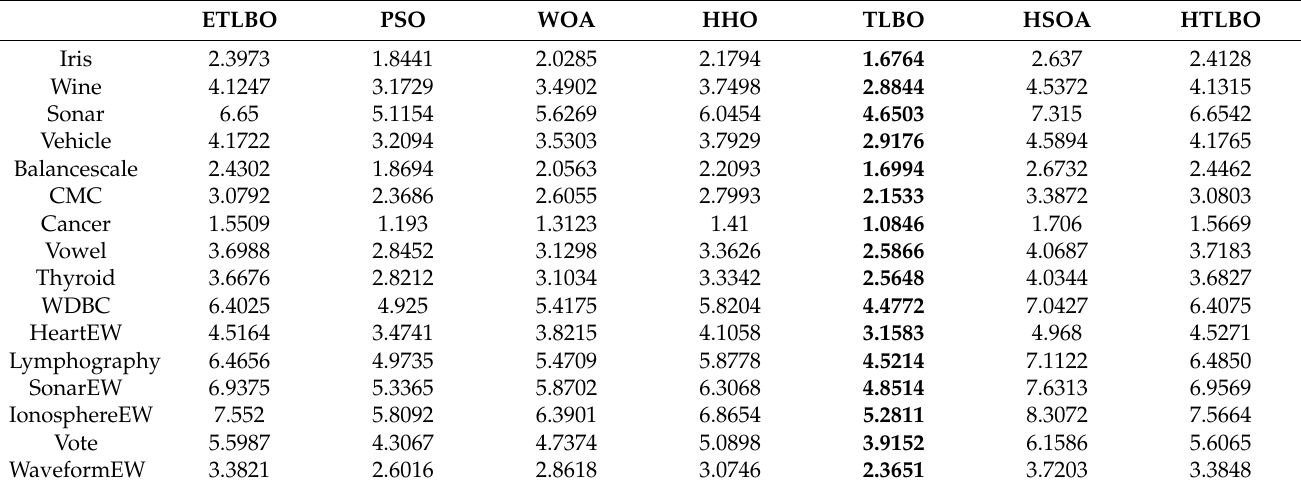
Table 10. The CPU time of the compared algorithms.